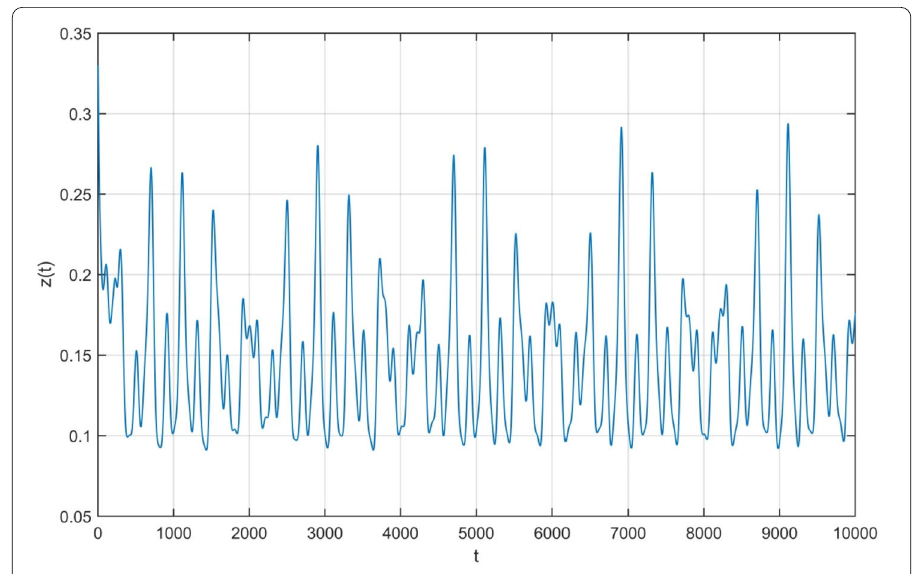
Figure 1 The trajectory z ( t ) of (3.12) for ϕ ( s ) = 0.33, s ∈ [–1,0]